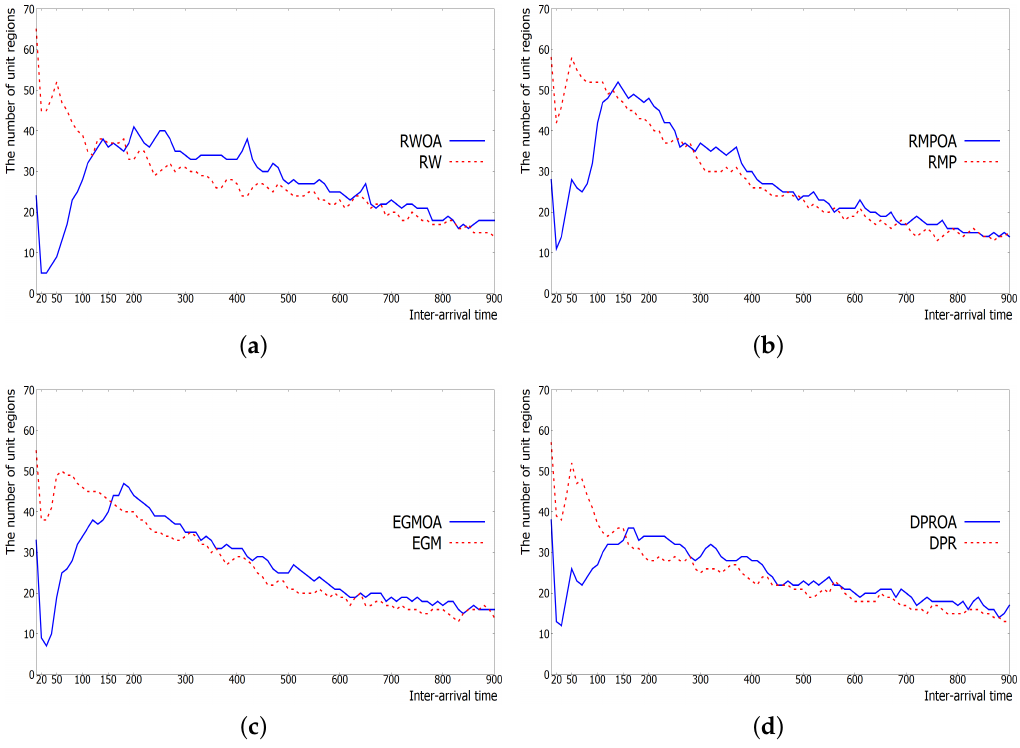
Figure 11. The number of unit regions per inter-arrival time with/without Overlap Avoidance: ( a ) Random Waypoint; ( b ) Random Markov Process; ( c ) Enhanced Gauss–Markov; and ( d ) Distributed Pheromone